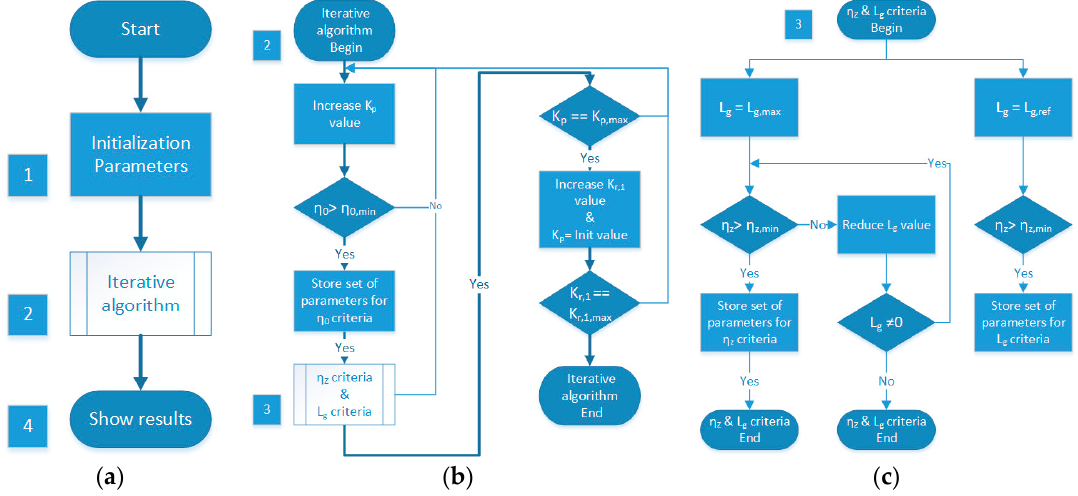
Figure 7. Flowchart diagram of proposed method for the design of PMR, ( a ) the main flowchart; ( b ) sub-process of iterative algorithm, step 2 of ( a ); ( c ) sub-process of η z & L g criteria, step 3 of ( b ). After the initialization of the optimization parameters (step 1), the grid inductance L g , ref , the k